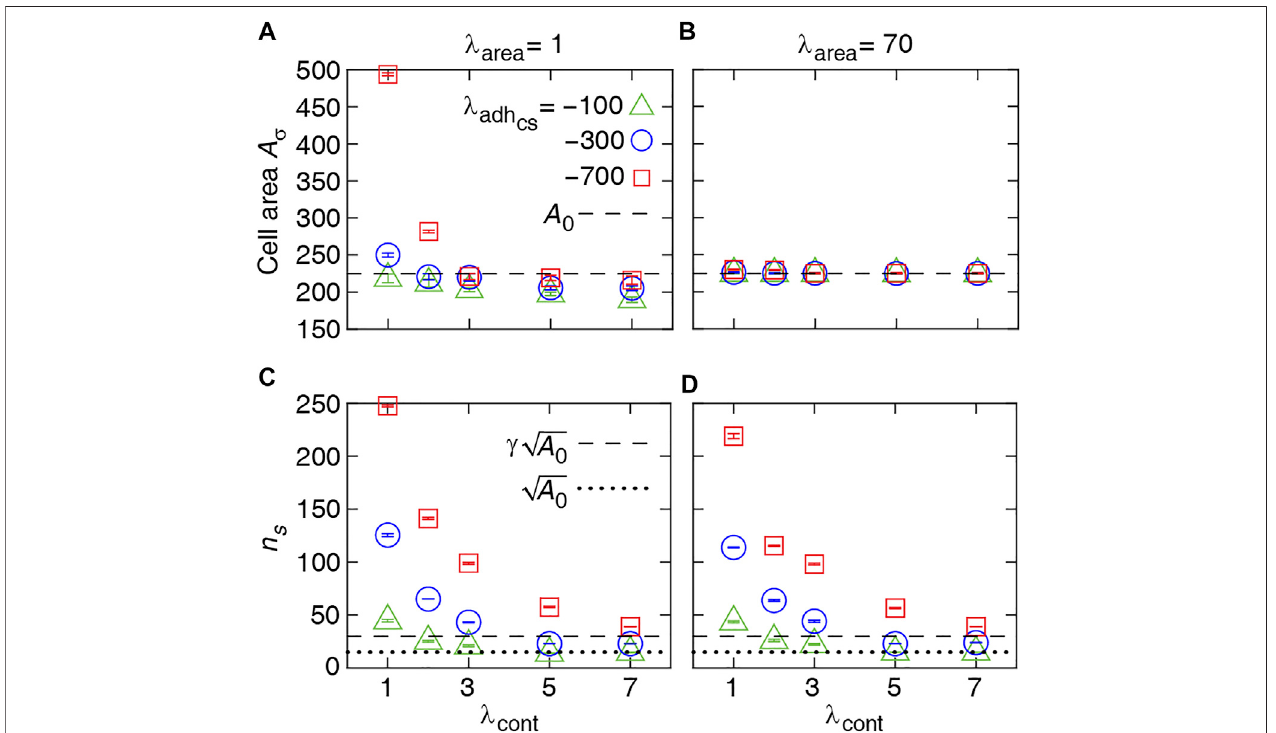
FIGURE 2 | Numerical results for single-cell properties. (A, B) Area of the cell in steady state versus contractility strength λ cont at various λ area and cell-substrate adhesion λ adh . (C, D) Number of cell-substrate adhesion sites n s in the steady state versus λ cont at various λ area and λ adh cs simulation run and corresponds to mean ± SD.